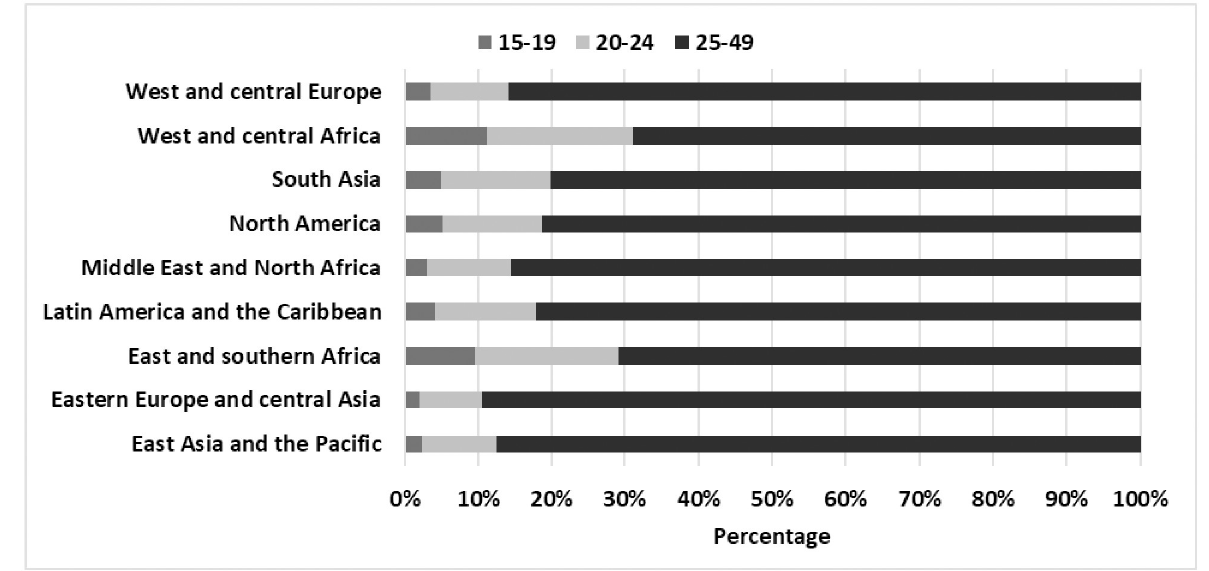
Fig 2. Distribution of population size estimates of female sex workers by age group and